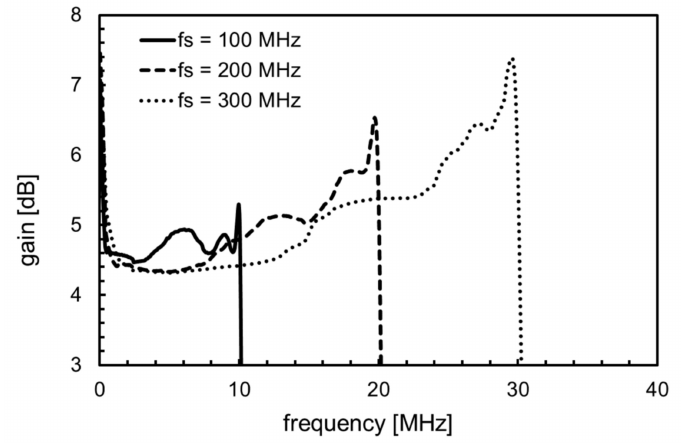
Figure 7. Detail of the LPF in-band response for different values of the sampling frequency.